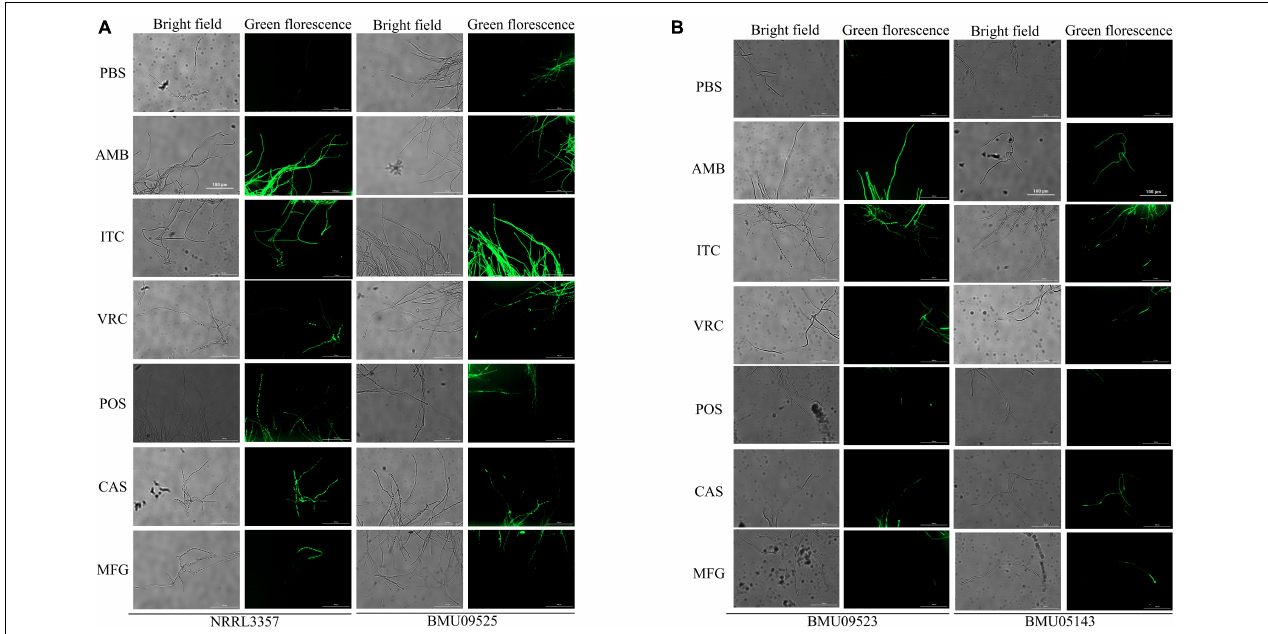
FIGURE 4 | Fluorescence microscope images showing endogenous ROS in (A) A. flavus . (B) A . terreus . Conidial were incubated at 37 ◦ C for 18 h before stained with 10 µ M DCF-DA for 30 min at 37 ◦ C in the dark. After a wash step, Fluorescence images were recorded after 2 h of incubation with drugs. AMB (32 µ g/ml), ITC